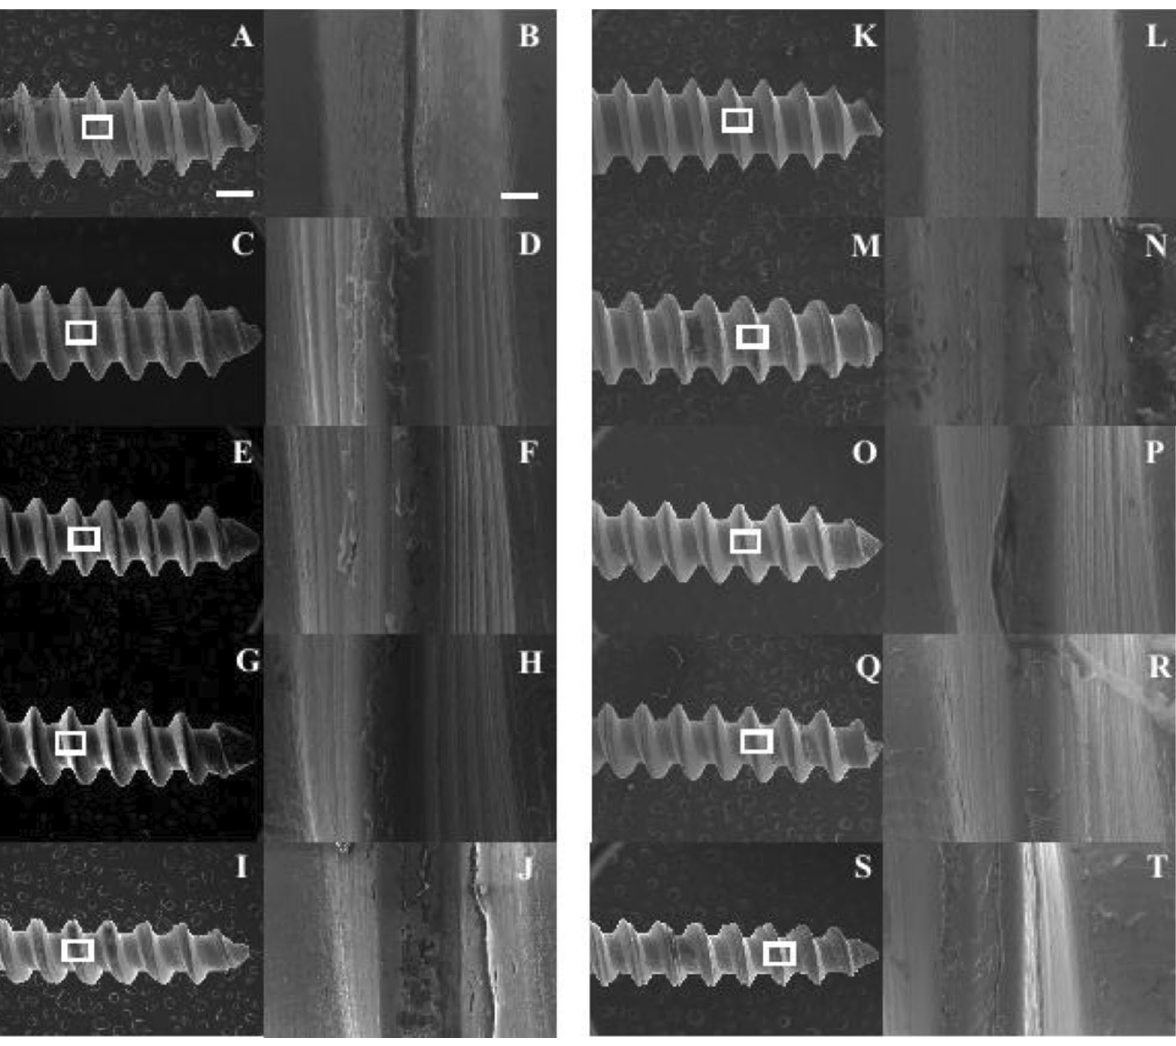
Figure 2. SEM images of unused and used miniscrews for 8 weeks after implantation. ( A ), ( B ), ( C ), ( D ), ( E ), ( F ), ( G ), ( H ), ( I ), and ( J ) Unused miniscrews. ( K ), ( L ), ( M ), ( N ), ( O ), ( P ), ( Q ), ( R ), ( S ), and ( T ) Miniscrews used for 8 weeks after implantation. ( A ), ( B ), ( K ) and ( L ): Ti-6Al-4 V miniscrews. ( C ), ( D ), ( M ) and ( N ): 1.3 mm diameter